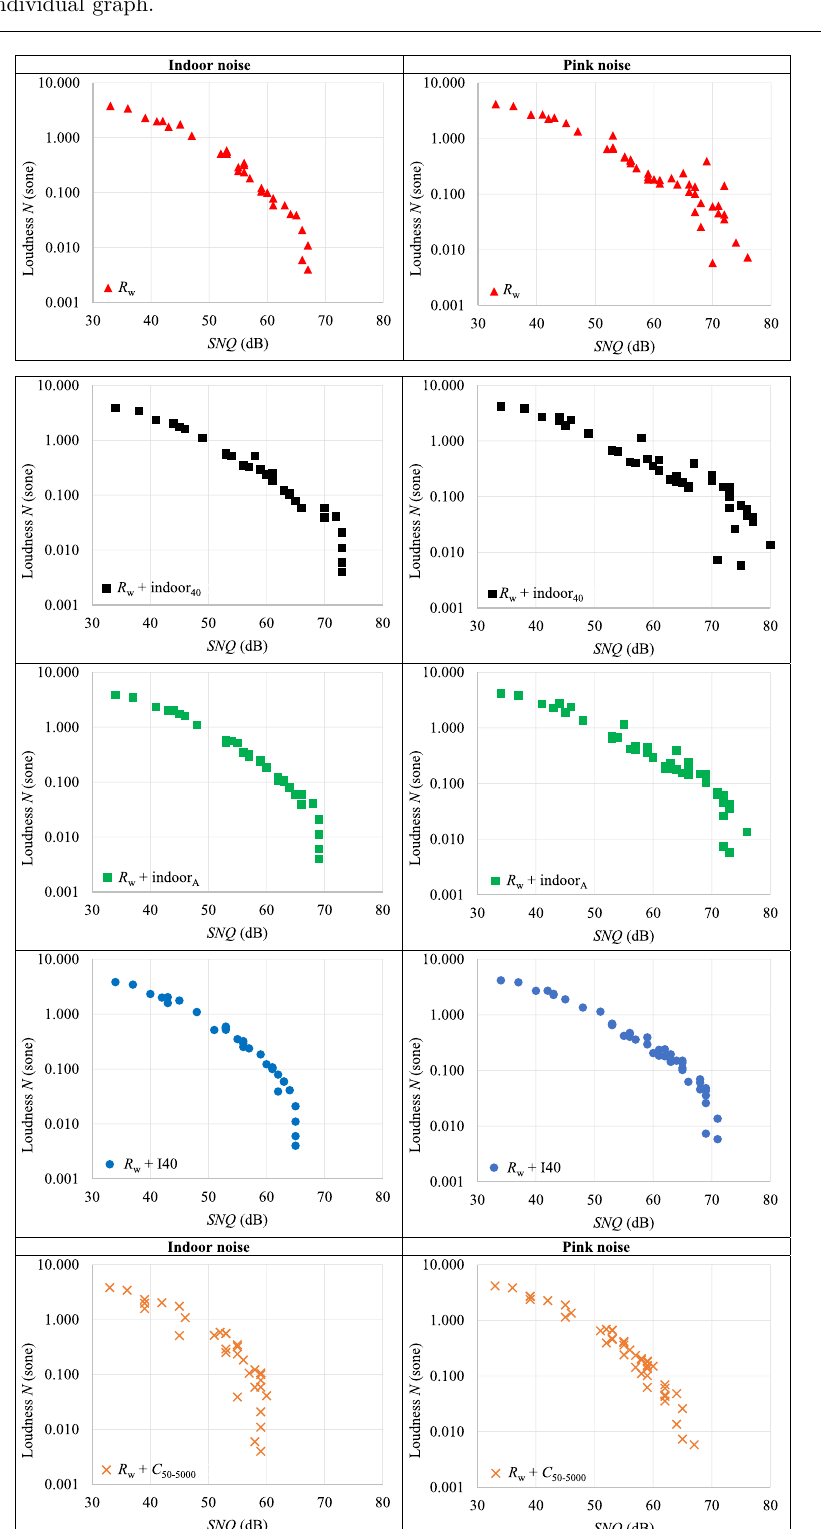
Table A2. Individual data used for summary graphs Figures 5 and 6. Correlation between the Zwicker ’ s Loudness values of transmitted sounds (in case of indoor noise and pink noise at the emitting side) and values of 8 SNQs for the tested walls. Each correlation is given in an individual